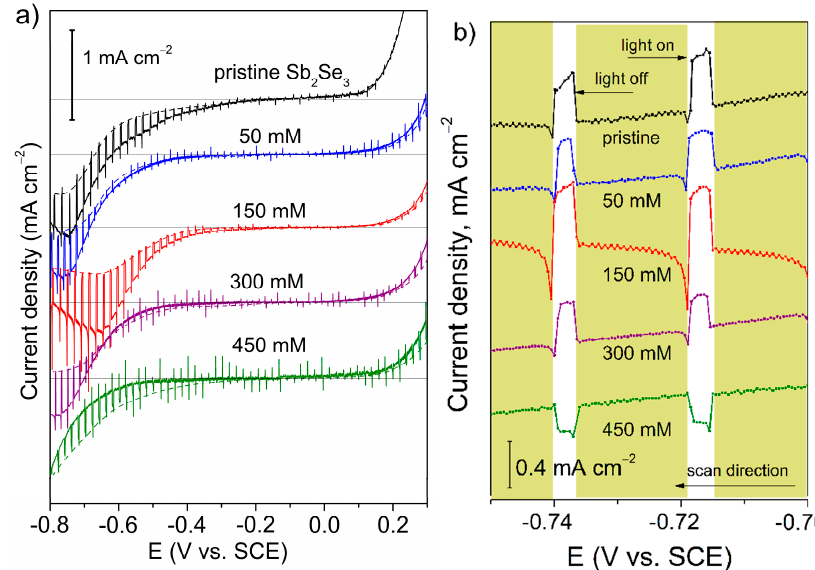
Figure 4. ( a ) Electrochemical characteristics of the pristine and thermally treated Sb 2 Se 3 films measured in the dark (dash line) and under chopped illumination (solid line) in the 0.1 M Na 2 SO 4 supporting electrolyte. ( b ) The enlarged photoelectrochemical characteristics recorded in the potential region from − 0.70 V to − 0.75V vs. SCE.